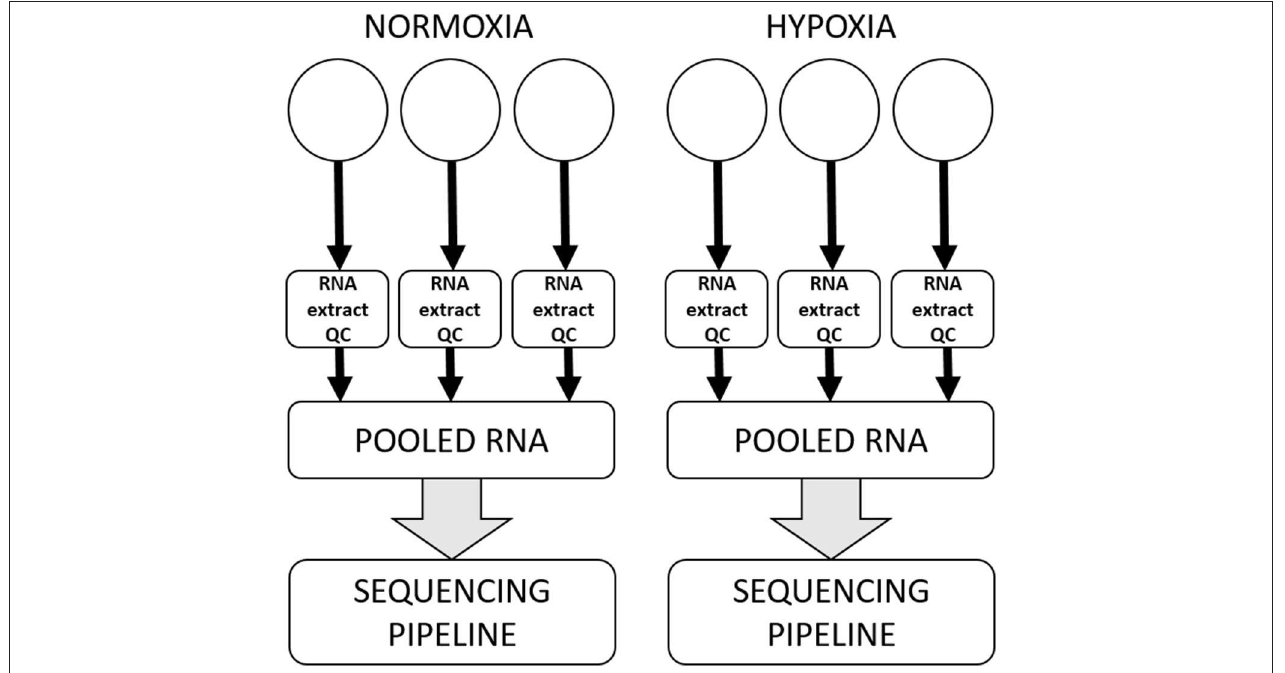
FIGURE 1 | Workflow for a single cell line in a single experiment. All cell lines were subjected to three separate experiments on three separate days, within which there were three technical replicates for each condition. RNA was extracted and subjected to quality control processes separately from each technical replicate, and then technical replicates were pooled to enter the sequencing pipeline.